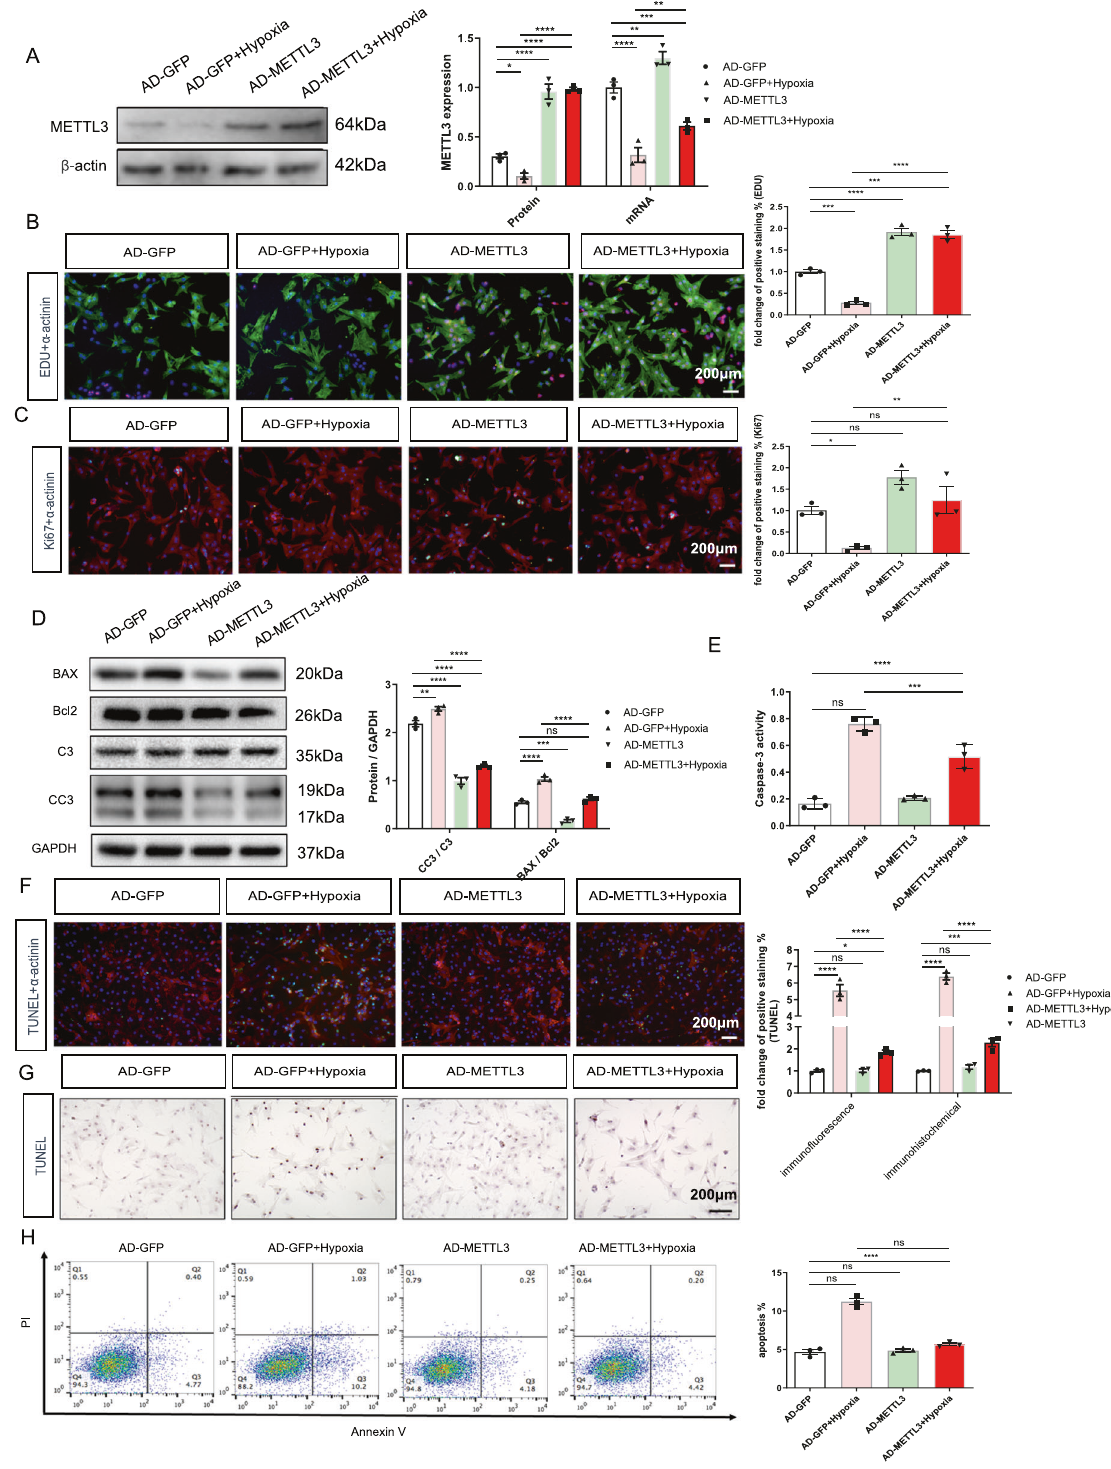
Fig. 2 METLL3 overexpression ameliorates hypoxia-induced decrease of proliferative capacity and increase of apoptosis in NRCMs. A Protein and mRNA expression of METTL3 in the NRCMs from different groups. B Representative immuno fl uorescence images of NRCMs labeled with EDU or α -actinin (EDU, red; α -actinin, green; DAPI, blue. Scale bars, 200 μ m). C Representative immuno fl uorescence images of NRCMs labeled with Ki67 or α -actinin ( α -actinin, red; Ki67, green; DAPI, blue. Scale bars, 200 μ m). D Protein expression of BAX, Bcl2, C3, and CC3 in the NRCMs from indicated groups. E Caspase 3 activities of NRCMs from indicated groups. F , G Representative immuno fl uorescence ( F ) and immunohistochemical ( G ) staining images of NRCMs labeled with TUNEL ( α -actinin, red; TUNEL, green; DAPI, blue. Scale bars, 200 μ m), and its quantitative analysis. H The results of fl ow cytometry on apoptosis in NRCMs. N = 3. The data were presented as the mean ±